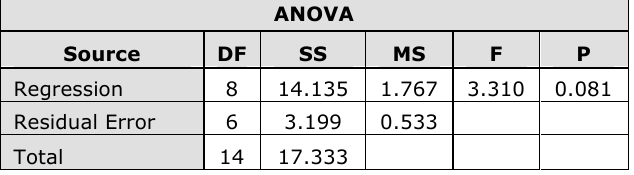
Table 4. “Analysis of Variance for Regression